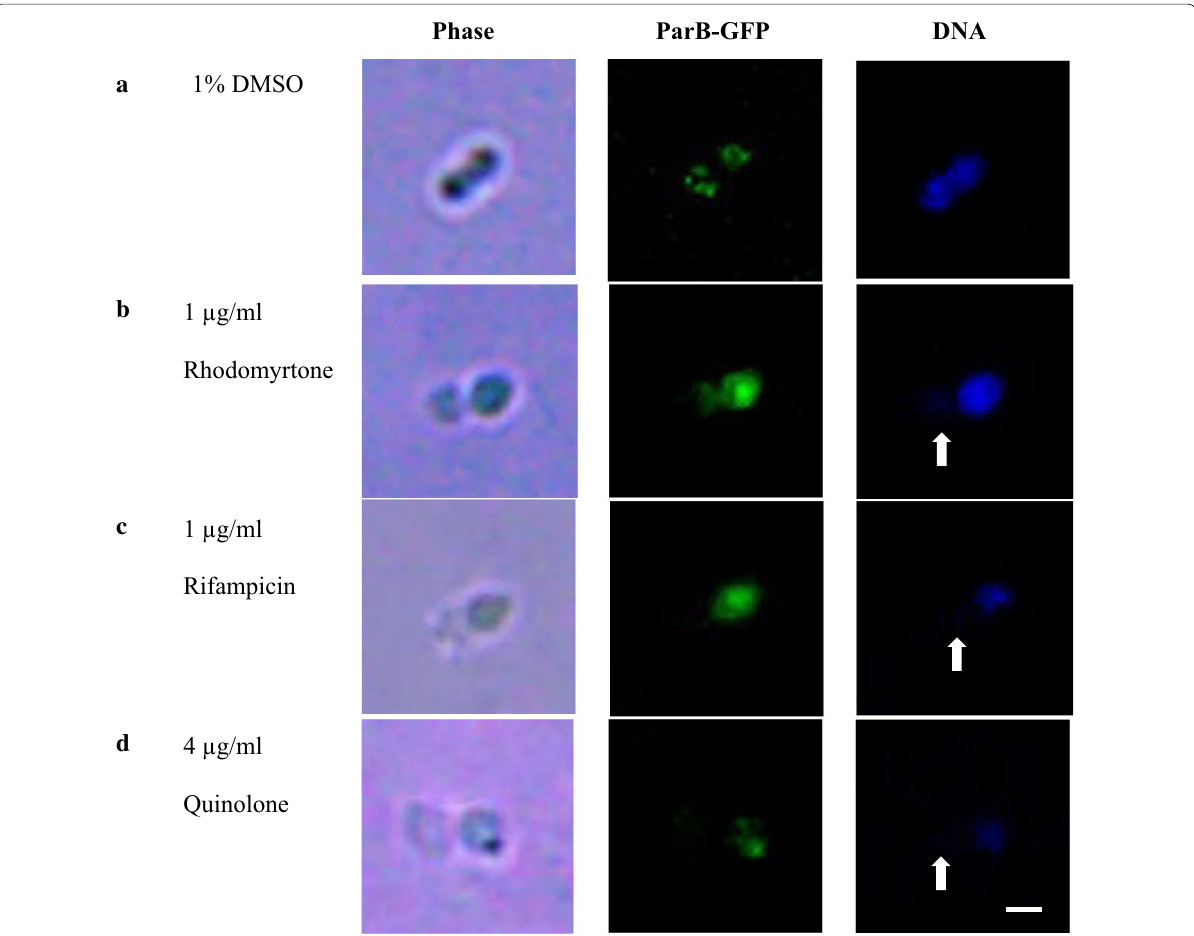
Fig. 4 oriC localization (ParB-GFP) and the presence of anucleated cells following rhodomyrtone treatment was visualized by fluorescence microscopy. a 1% DMSO, b 1 µg/ml rhodomyrtone, c 1 µg/ml rifampicin and d 4 µg/ml quinolone for 30 min. Phase-contrast images (Phase), ParB-GFP ( oriC ) localization (green) and DNA (blue). Anucleated cells were indicated by white arrows. Scale bar